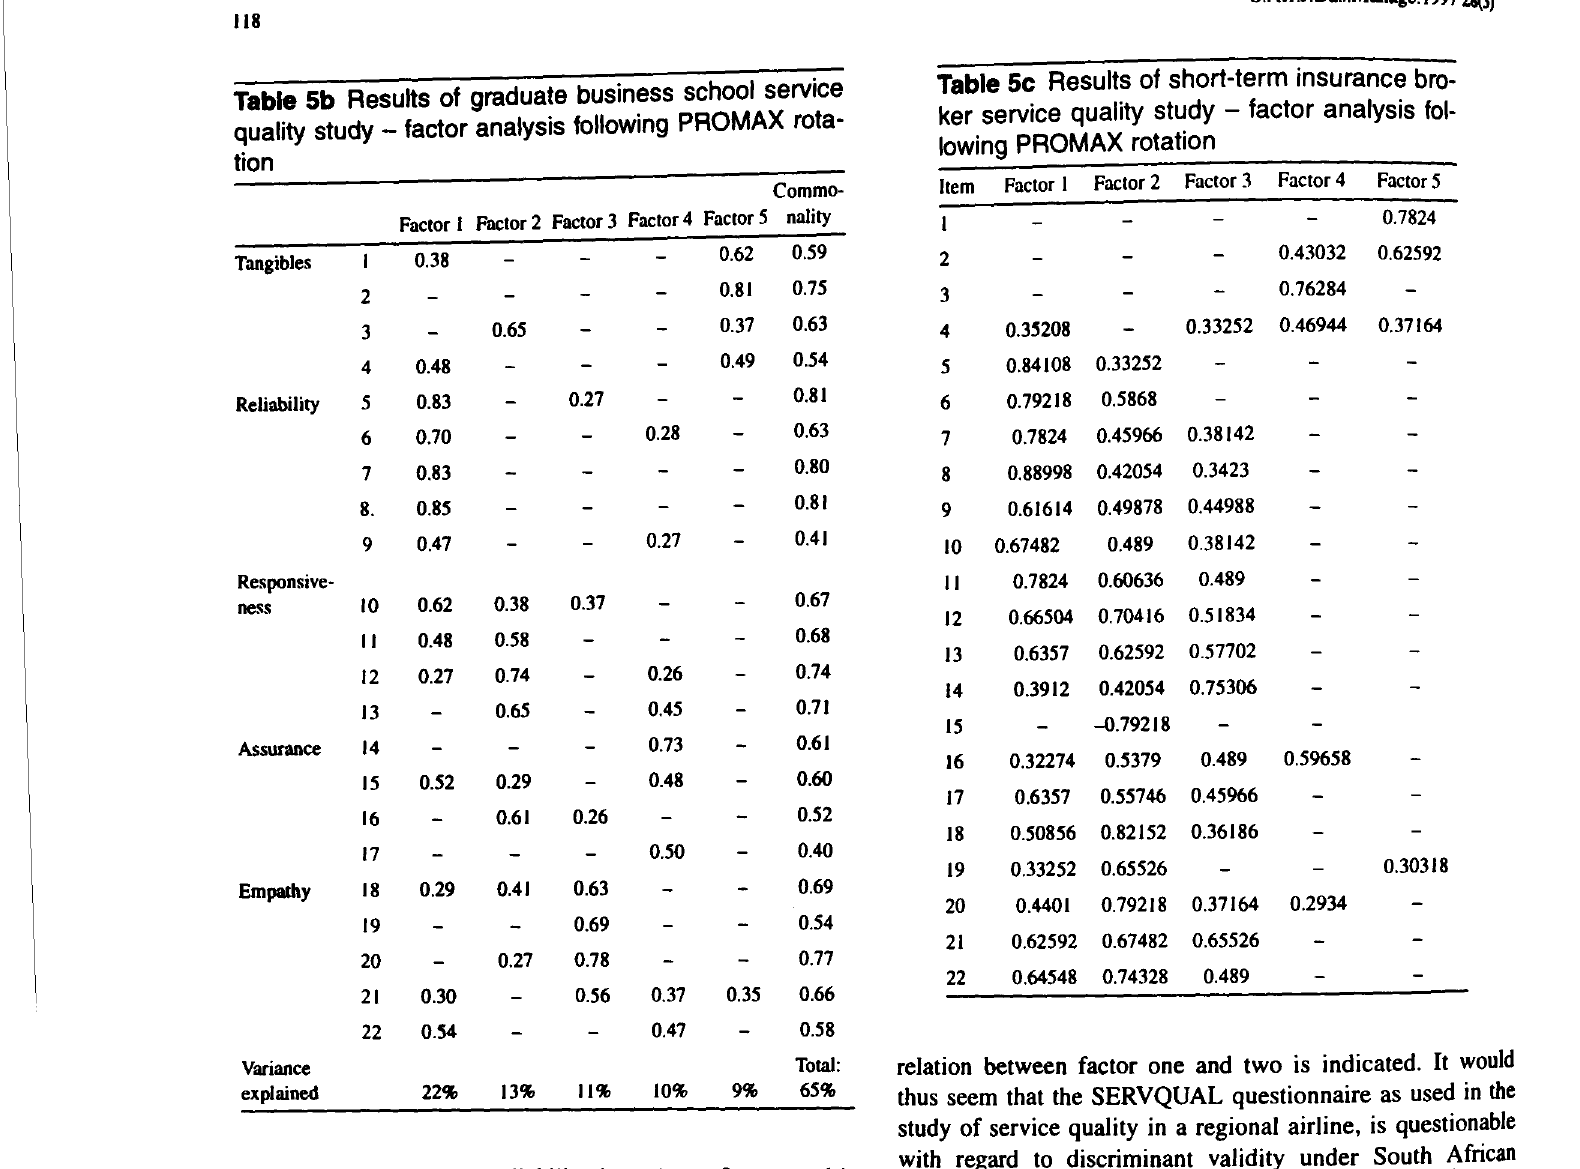
Table Sb Results of graduate business school service